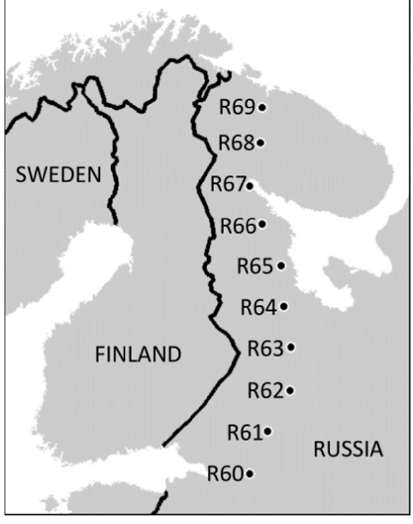
Figure 1. Locations of the study sites (reproduced with permission from [28]). For detailed information on study sites consult Tables S1 and S2 in the Supplementary Materials.